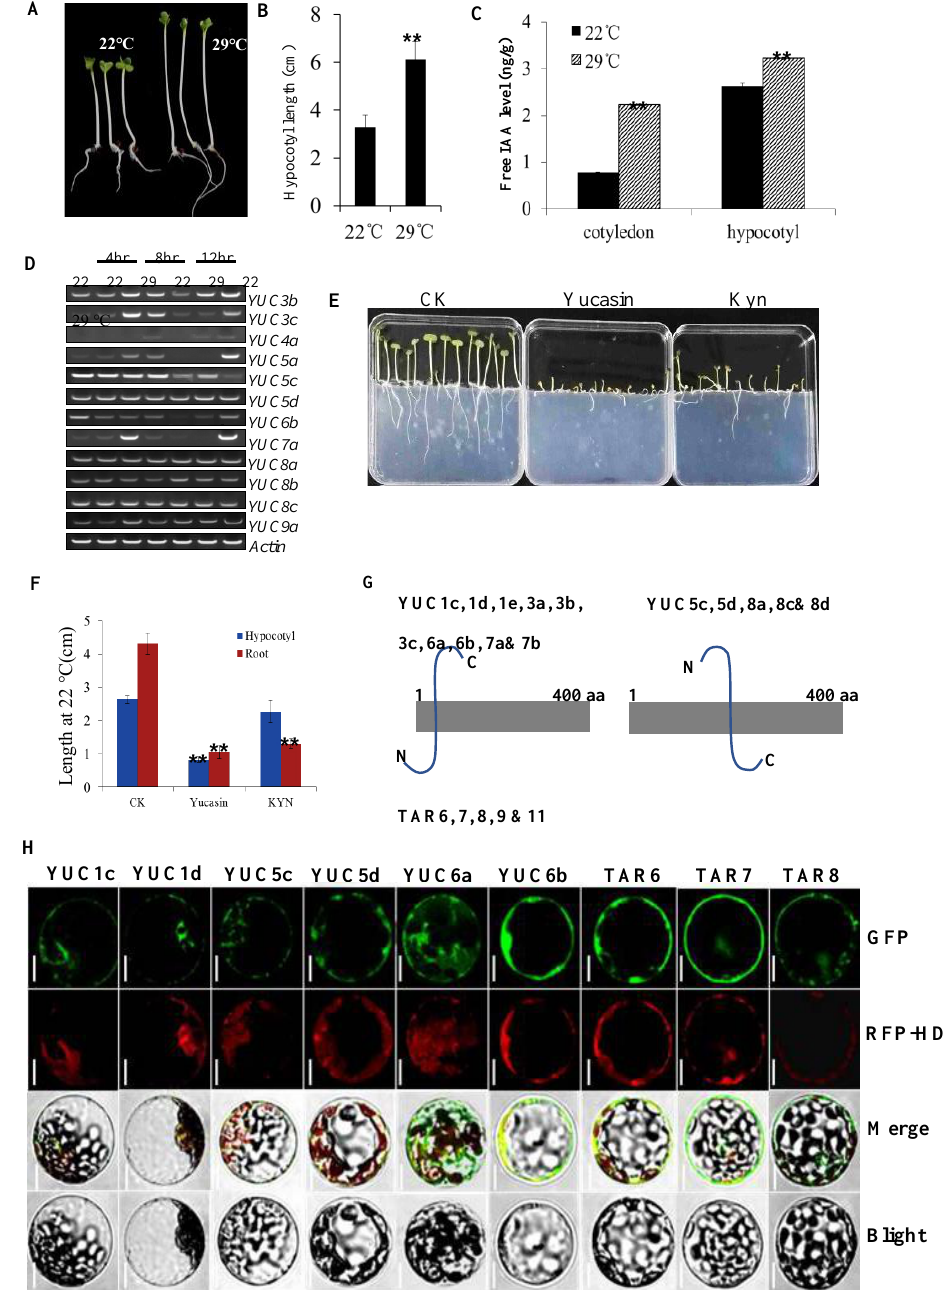
Figure 3. Seedlings treated with auxin biosynthesis inhibitor or different temperatures, and subcel- lular analysis of auxin biosynthetic genes in oilseed rape. ( A ) Seedling grown for 5 days at 22 °C and 29 °C. ( B ) The seedlings displayed elongated hypocotyls at high temperatures. Asterisks indicate significant differences from the control (** p < 0.01, Student’s t test). ( C ) Free IAA levels in the coty- ledons and hypocotyl at 5 days. Asterisks indicate significant differences from the control (** p < 0.01, Student’s t test).( D ) Higher temperatures induced YUC gene expression in B. napus. ( E ) Effects of yucasin and kynurenine on B. napus seedlings grown in MS medium with 100 μ M concentrations for 5 days. ( F ) Effects of yucasin and kyn on hypocotyl elongation of seedlings. Asterisks indicate significant differences from the control (** p < 0.01, Student’s t test). ( G ) Trans-membrane structure analysis of TAR and YUC protein. ( H ) Localization of auxin biosynthetic proteins by transient ex- pression in Arabidopsis protoplast. Co-expression of ER localized marker HDEL-RFP with BnaTAR-GFP or BnaYUC-GFP proteins were analyzed. Bars = 10 μ m.